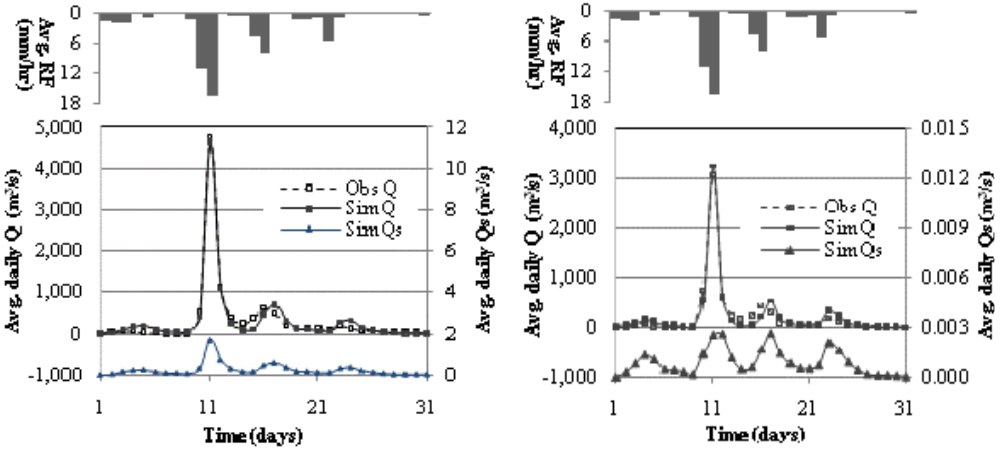
Fig. 7. Daily avg. water and suspended sediment discharge.